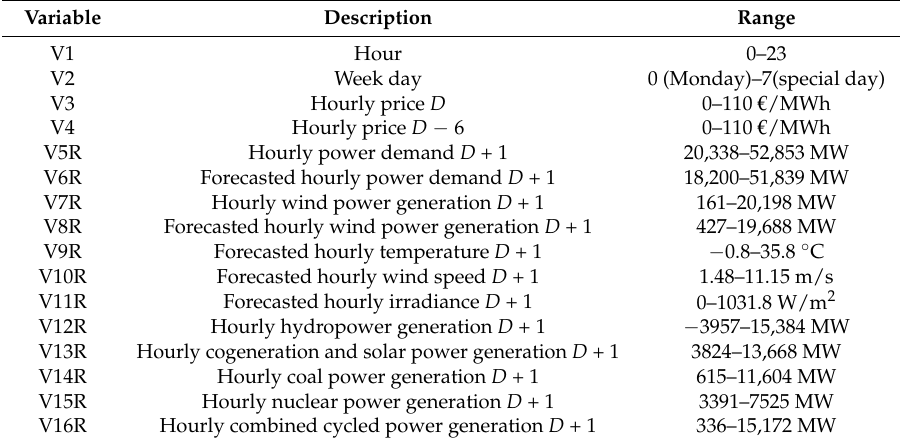
Table 3. Variables of reference models for price estimation (RMPE